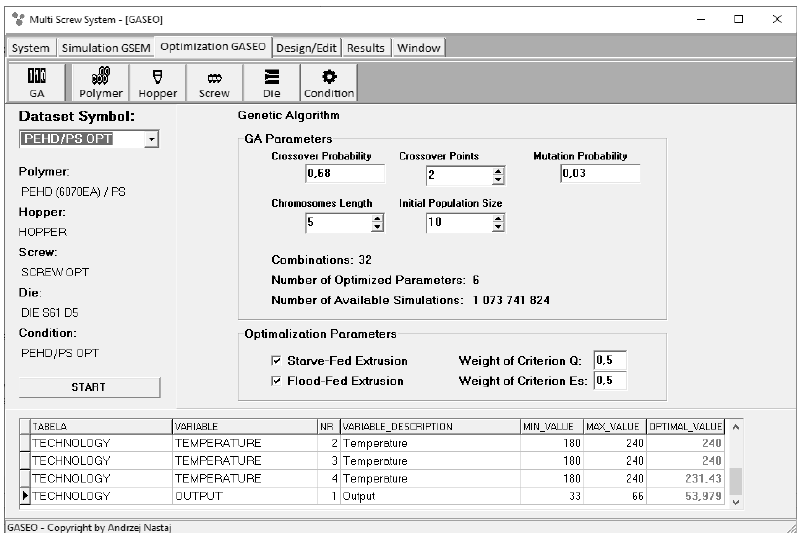
Figure 5. Execution of Genetic Algorithms: selection of initial population and evaluation of chro- mosome adaptation [68].